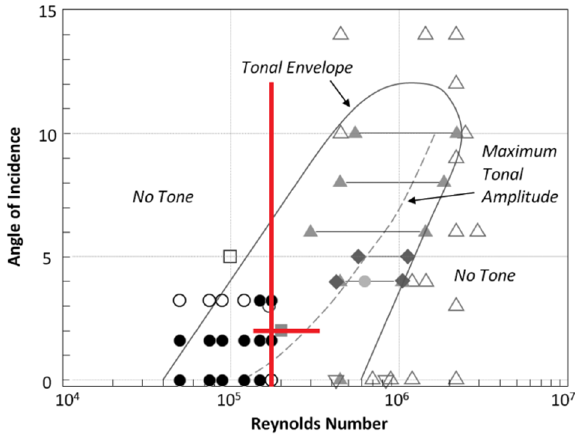
Figure 4. Integrated plot adapted from Lowson et al. [19] and Arcondoulis et al. [20] indicating NACA-0012 tone-producing and no-tone-producing regions according to experimental and numerical studies of Desquesnes et al. [16] (squares), Lowson et al. [19] (diamonds), Arcondoulis et al. [20] (circles), Paterson et al. [1] (triangles), and Arbey and Bataille [10] (inverted triangles). Filled markers represent tone-producing regimes, while unfilled markers represent no-tone-producing regimes. Tonal envelope and maximum tonal amplitude (dashed) line are from experiments by Lowson et al. [11]. Red lines indicate regimes investigated by Nguyen et al. [18].